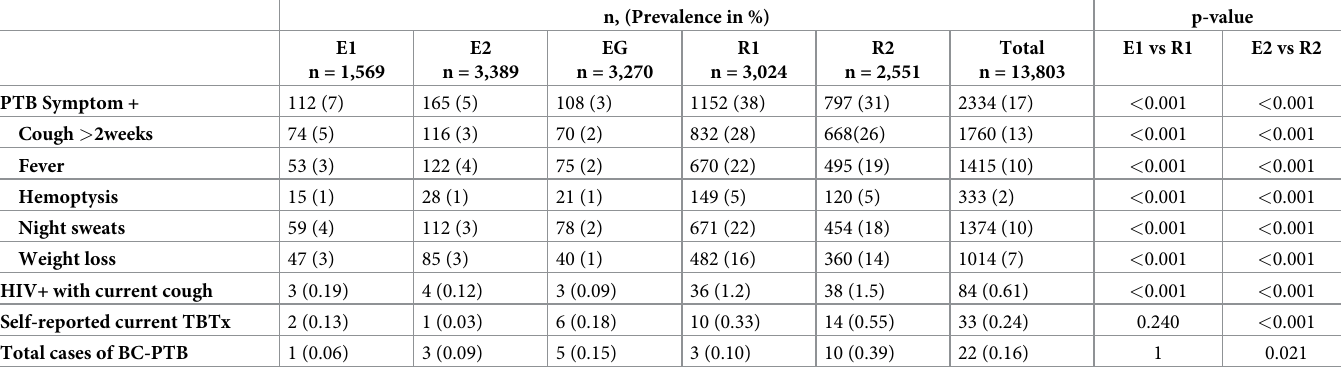
Table 2. Prevalence of PTB symptom screen and bacteriologically confirmed-PTB cases.